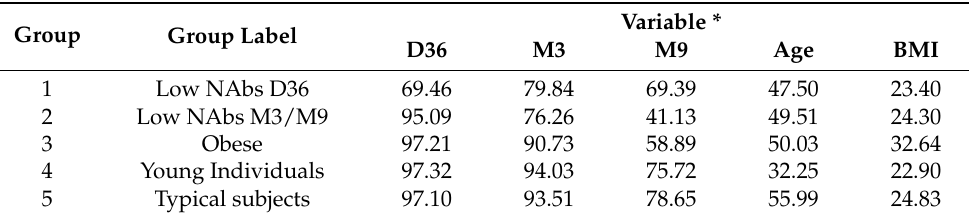
Table 3. Characteristics of each group formed by k-means cluster analysis. Values refer to the mean estimates for each category. Group Group